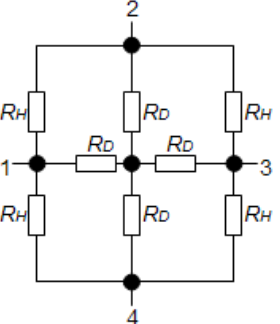
Figure 2. An equivalent model topology for the 90°symmetry Hall